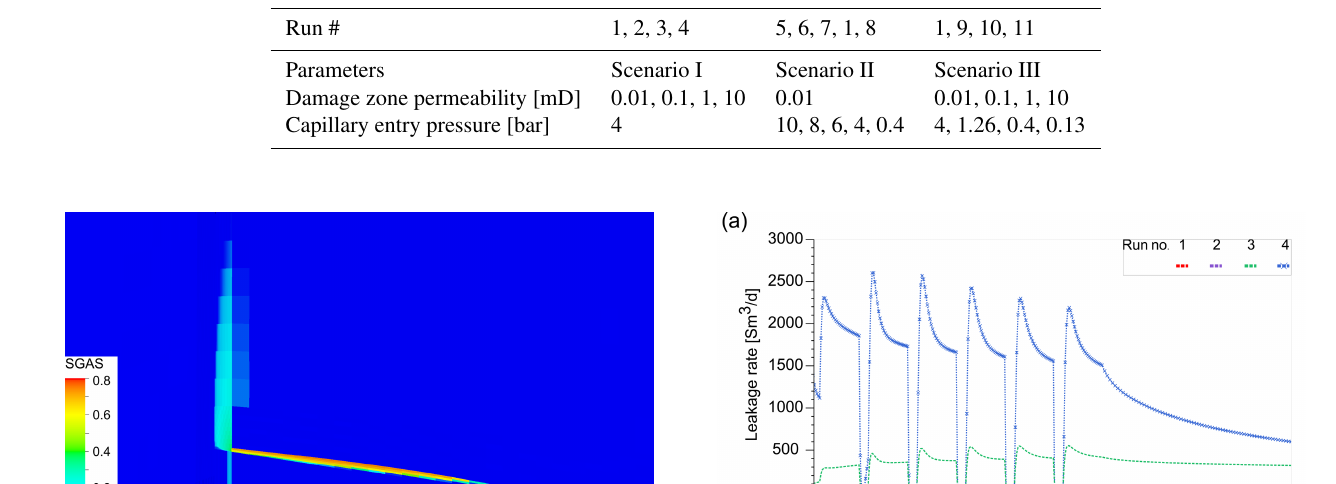
Table 2. Model parameters used for leakage scenario simulations.